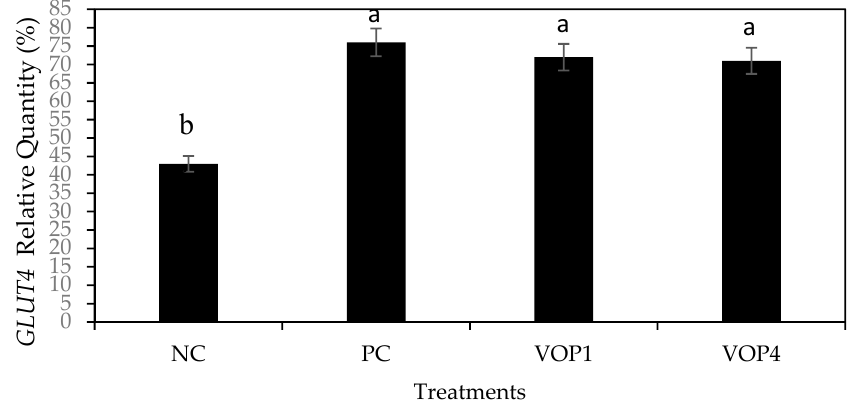
Figure 8. The GLUT4 gene expression in C2C12 skeletal mouse muscle cells in presence of leaf extracts 50 mg/µL (100 µL) of cowpea cultivars VOP1 and VOP4 after 3 h of incubation. NC—negative control, PC—positive control (Insulin). Bar with same alphabets are not significantly different between cultivars at p < 0.05. Data obtained were subjected to analysis of variance (ANOVA) using the statistical programme. Each bar represents the mean and standard deviation ( n = 3).